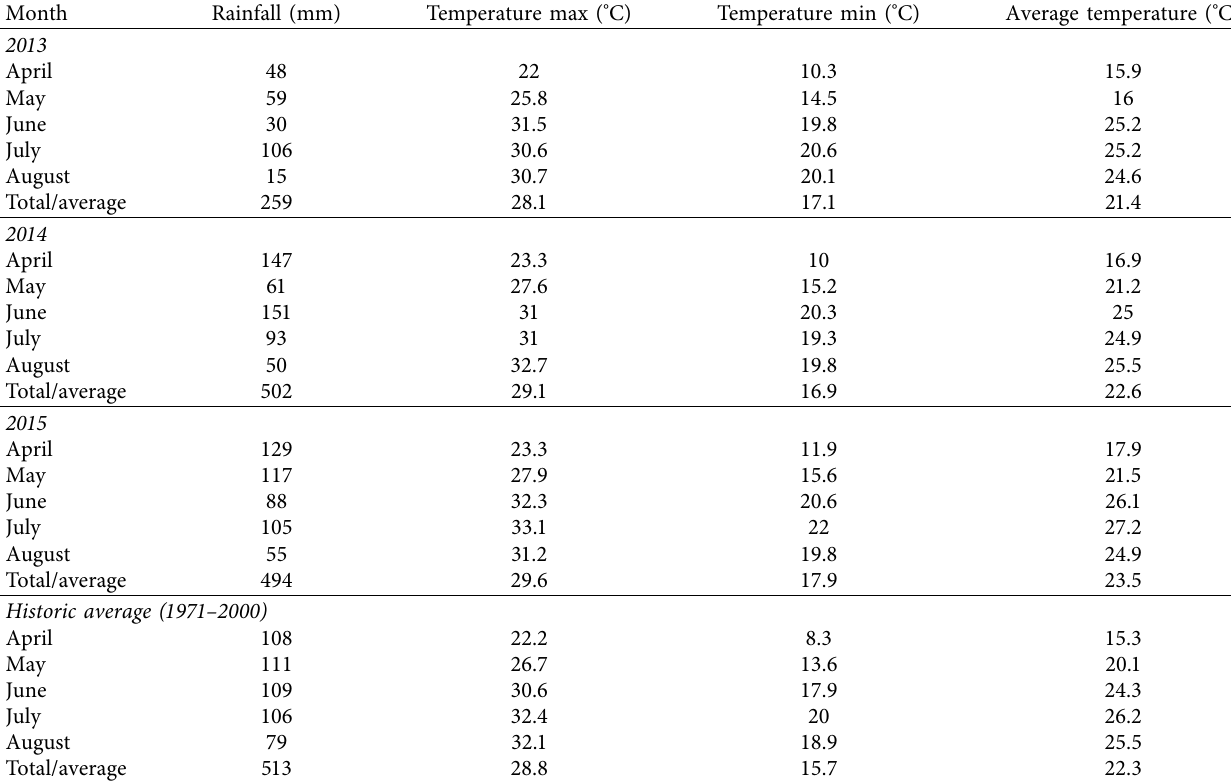
Table 3: Monthly average climatic conditions, during the 2013, 2014, and 2015 growing seasons and long-term average values (30 years) measured at the research site TVREC.